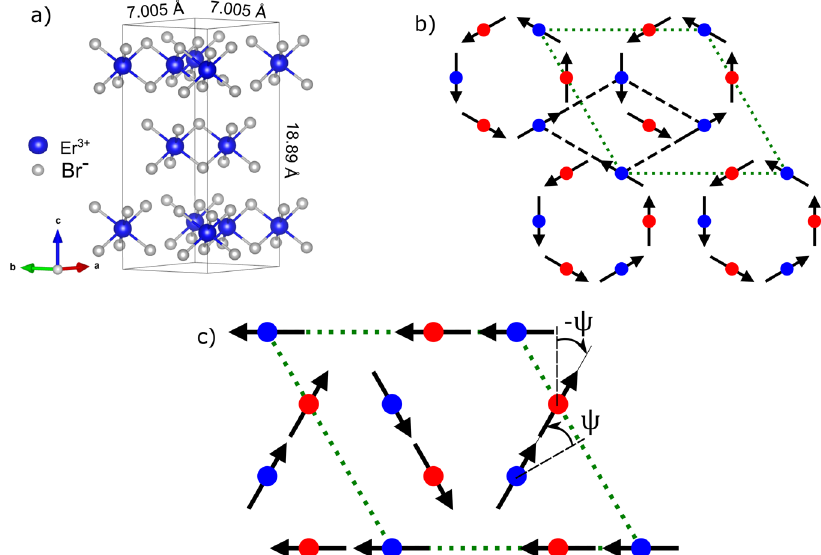
Fig. 1 Crystal and magnetic structure of ErBr 3 . a Crystal structure of ErBr 3 . Br − ions octahedrally coordinate Er 3 + ions that form honeycomb layers stacked along the c -axis. b Honeycomb layer of Er 3 + ions at z = 1/6 with ordered magnetic moments of 4.7 μ B (black arrows) for a spin con fi guration given by angle Ψ = 0. The two trigonal sublattices of the honeycomb are shown as blue and red spheres. The crystallographic and magnetic unit cells are shown as black and green lines, respectively. c The classical magnetic ground state is continuously degenerate and the magnetic moments can be rotated in opposite direction by varying the angle Ψ . In panel c , Ψ = π